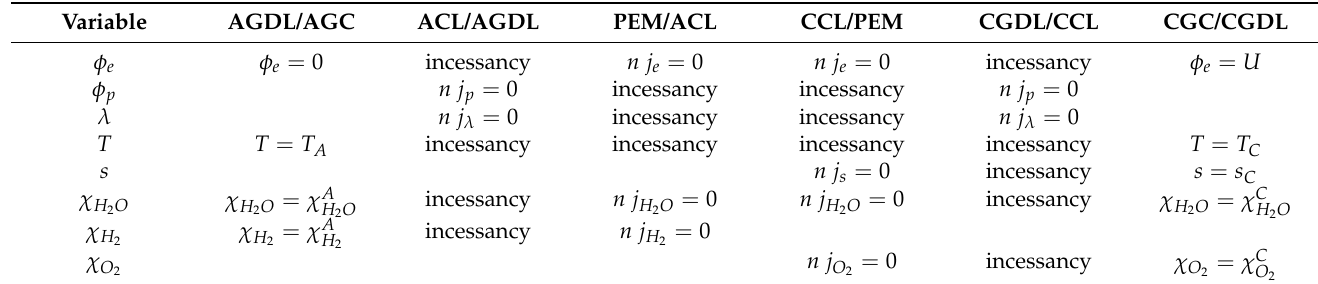
Table 3. Boundary conditions.